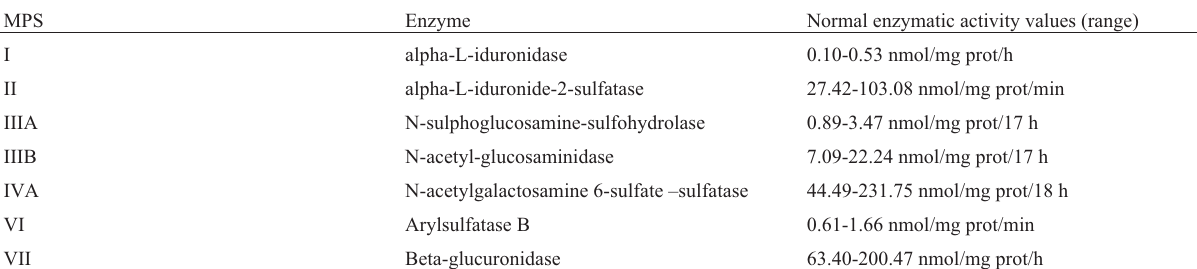
Table 1 - Reference values in the healthy Mexican